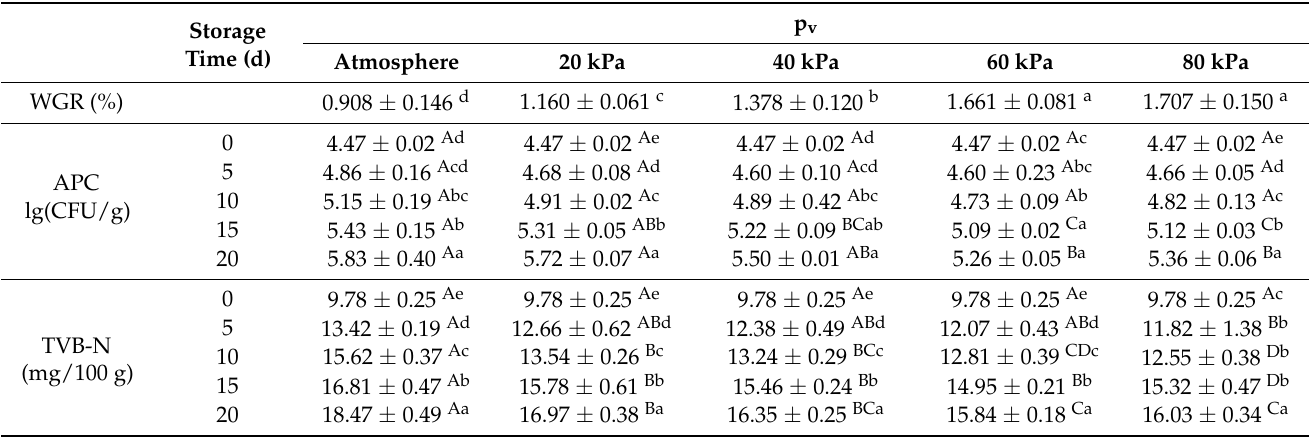
Table 4. Changes of WGR, APC and TVB-N of tilapia fillets under different p v with fixed t 1 and t 2